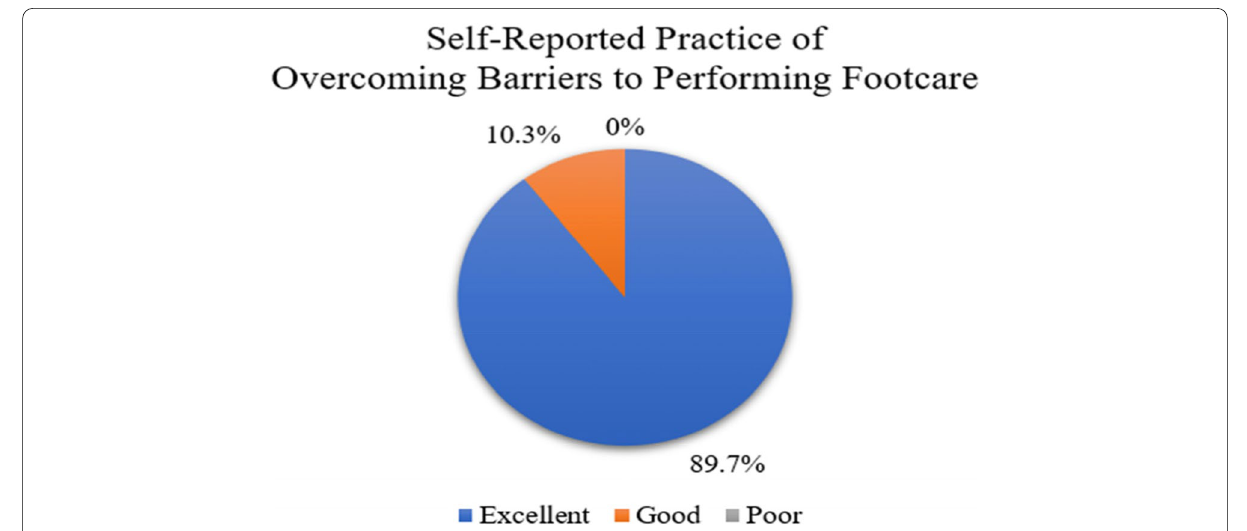
Fig. 6 Distribution of the self‑reported practice of overcoming barriers to performing footcare ( n